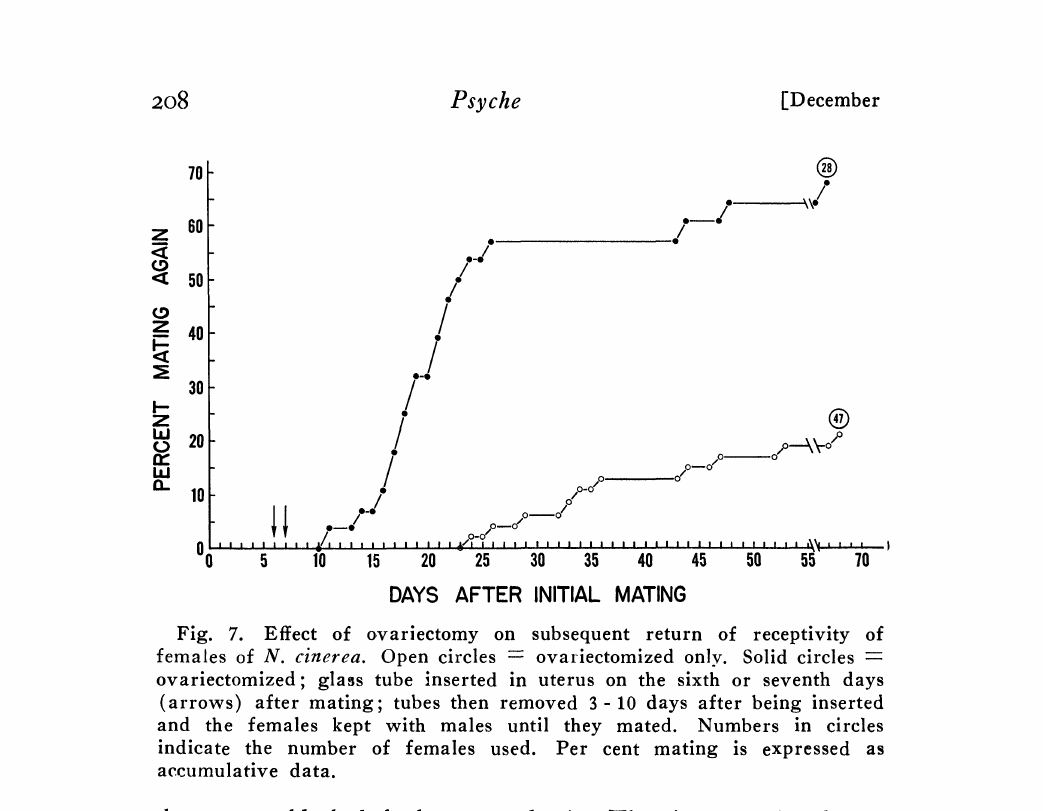
Fig. 7. Effect of o,variectomy on subsequent return of receptivity of females of N. cinerea. Open circles ovariectomized only. Solid circles ovariectomized; glas tube inserted in uterus on the sixth or seventh days (arrows) after mating; tubes then removed 3-10 days after being inserted and the females kept with males until they mated. Numbers in circles indicate the number of females used. Per cent mating is expressed as accumulative